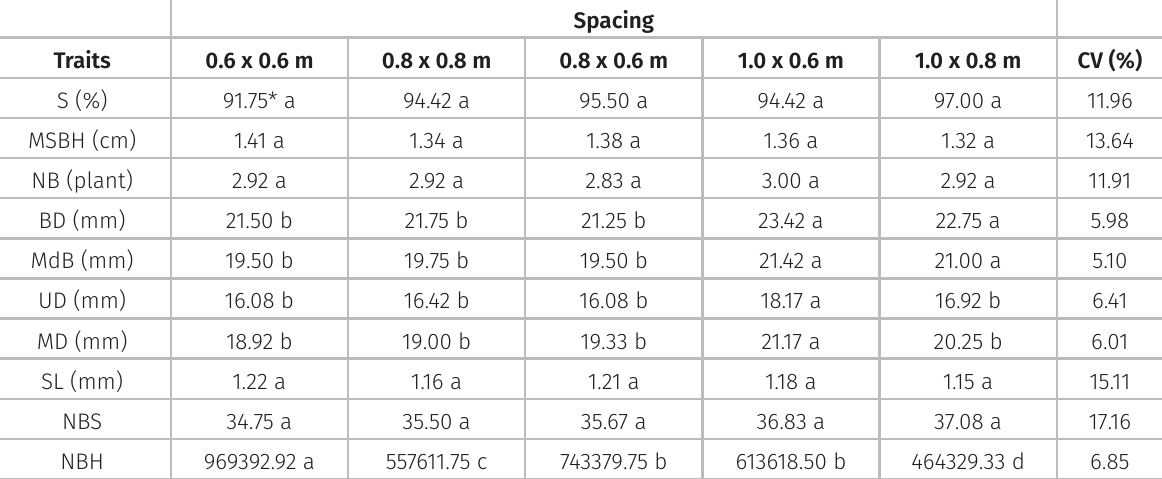
Table II. Percentage of survival (S%), main stem branching height (MSBH), number of branches (NB), stem base diameter (BD), stem middle diameter (MdD), stem upper diameter (UD), mean stem diameter (MD), stem length (SL), number of buds per stem (NBS), and number of buds per hectare (NBH) of cassava plants at spacings of 0.6